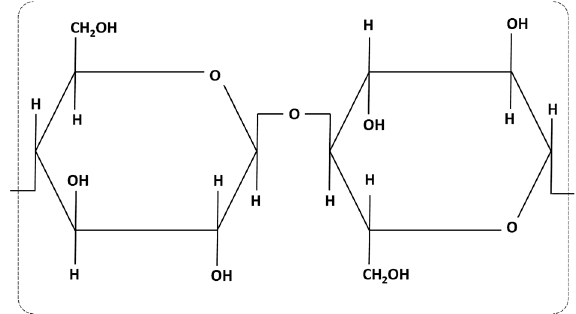
Figure 1. Building block of cellulose polymer.